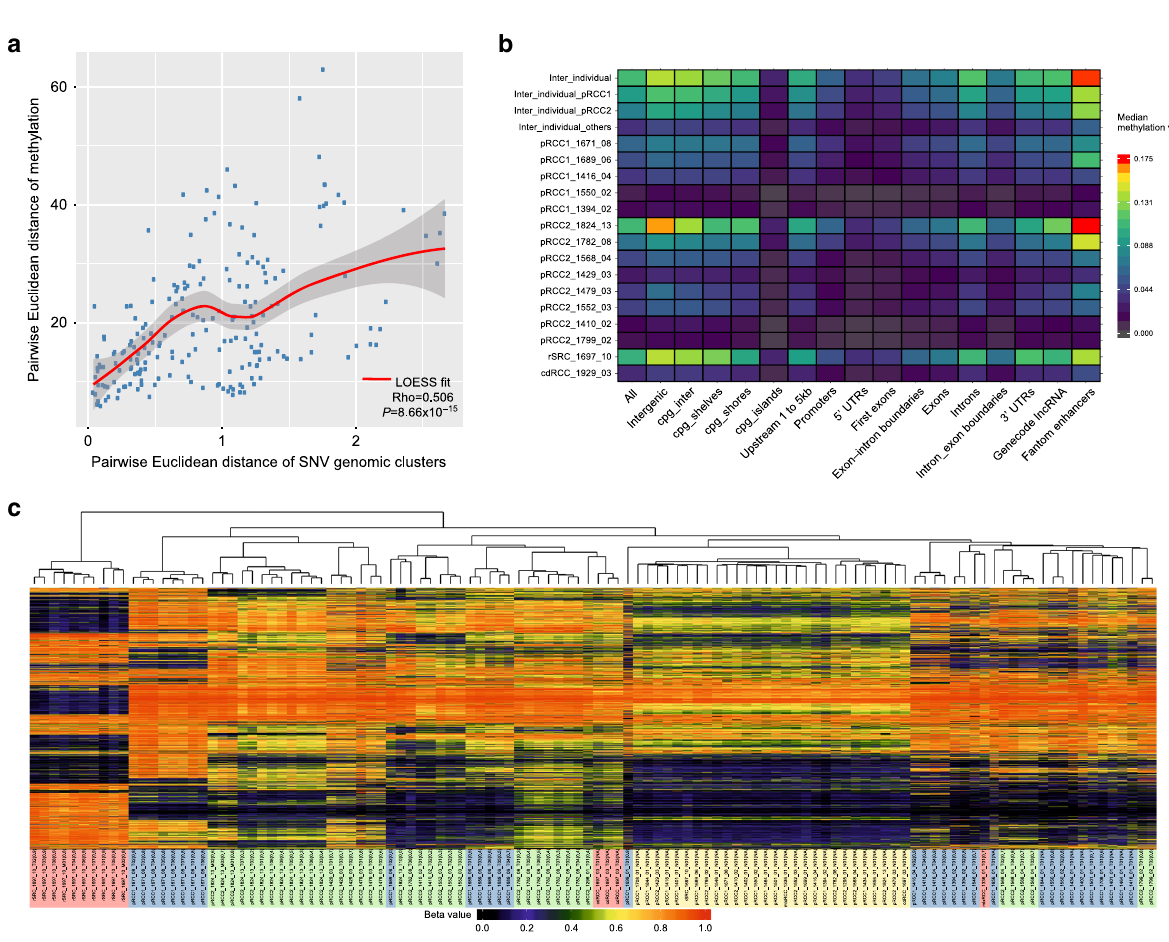
Fig. 5 Intratumor heterogeneity (ITH) of methylation pro fi les. a Scatter plots of pairwise distance between methylation and single nucleotide variant clusters. LOESS (Locally Weighted Scatterplot Smoothing) fi tted curve is shown in red line with 95% con fi dent interval in gray shaded area. Spearman ’ s rank correlation rho is shown on the bottom right. For the two-sided test of rho = 0, the test statistic S is 719790 based on the algorithm AS 89. The exact P value is 8.66 × 10 − 15 . b Methylation ITH on genomic regions for each sample and tumor subtype. c Unsupervised hierarchical clustering of methylation pro fi les measured by the methylation level as beta value for the top 1% most variable methylation probes. Sample IDs are followed by the purity estimated by SCNAs or SNV VAF in parentheses. The background colors of the sample IDs represent different histological subtypes and tumor or normal tissue